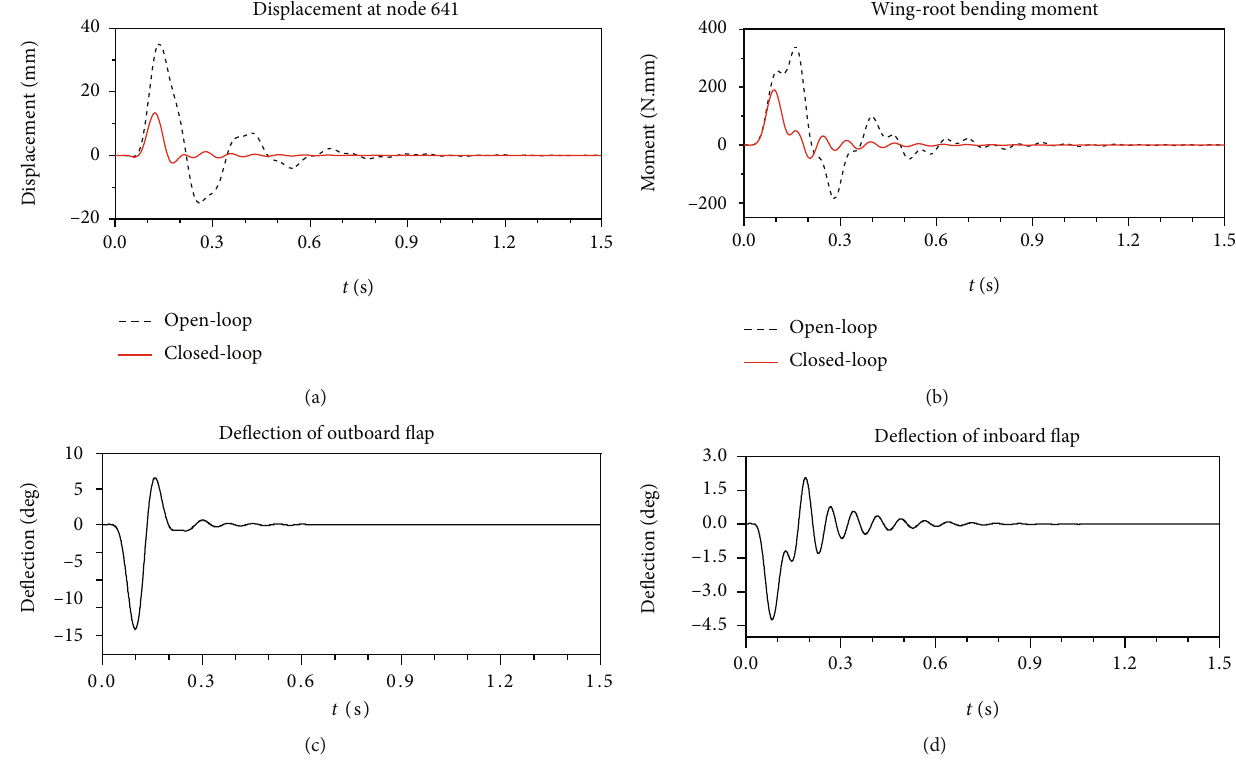
Figure 18: Dynamic responses of the open and closed-loop systems to the 1-cos discrete gust ( θ = 0 deg, U